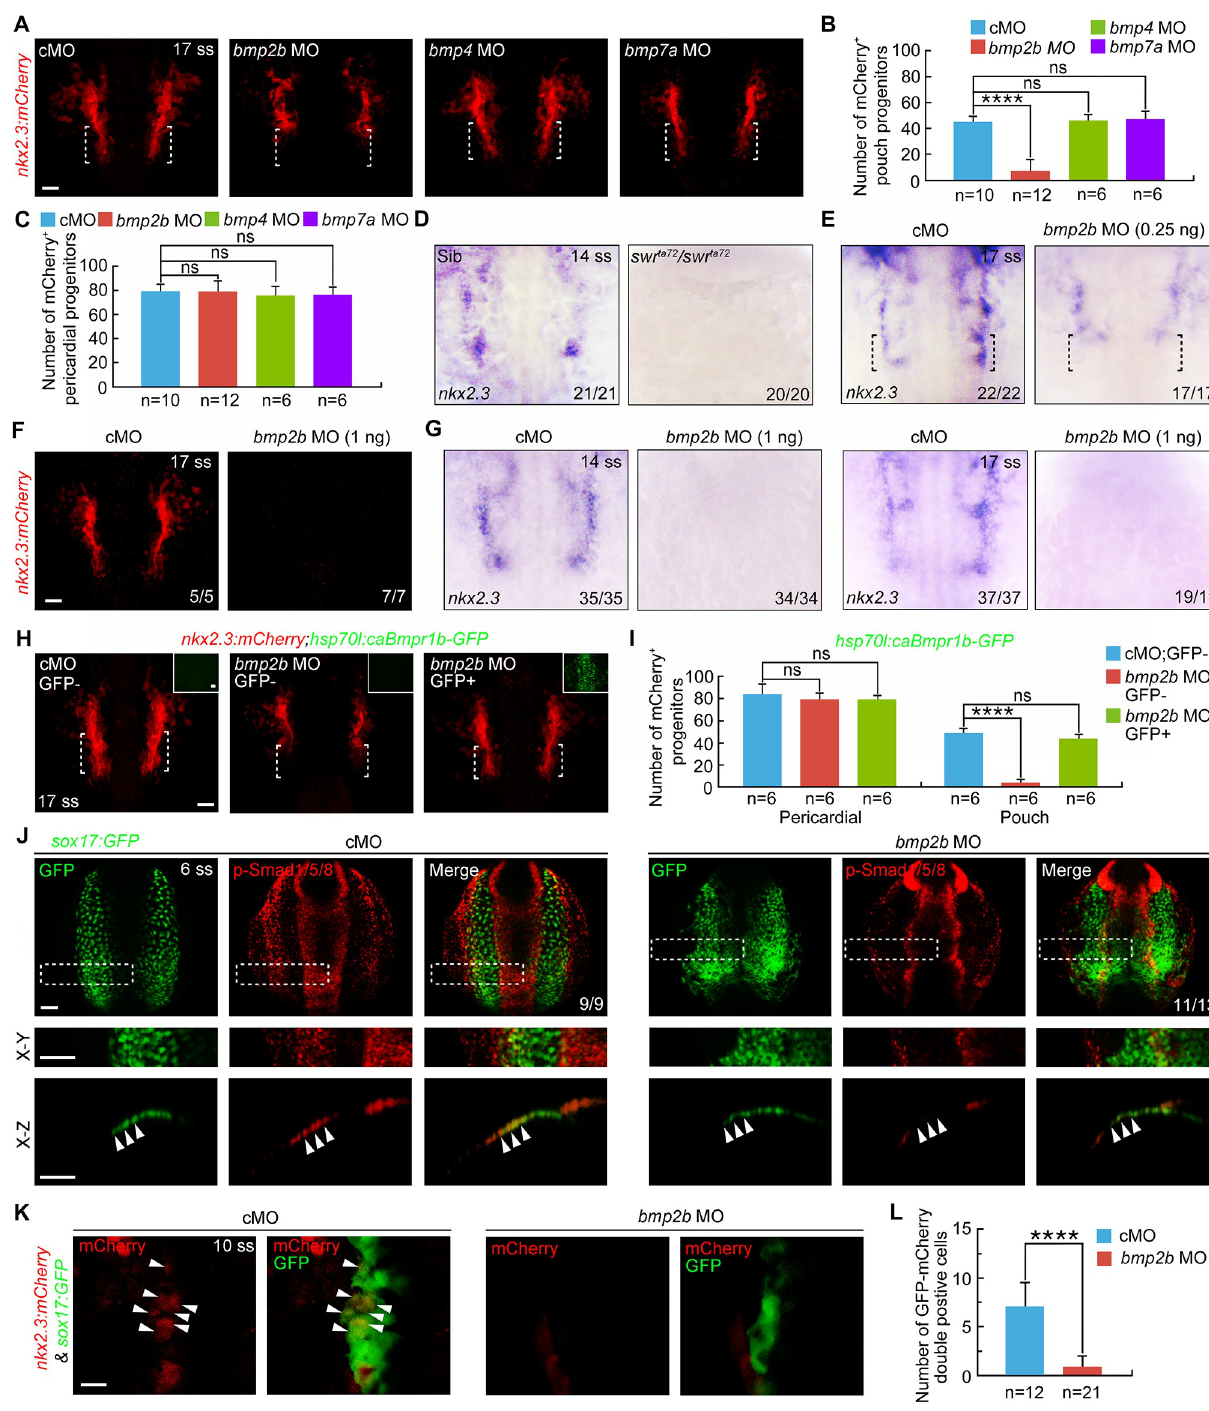
Fig 7. bmp2b is necessary for pharyngeal pouch progenitor specification. ( A ) mCherry fluorescence at the 17-somite stage in Tg(nkx2 . 3 : mCherry) embryos injected with 4 ng cMO, 0.25 ng bmp2b MO, 2 ng bmp4 MO, and 4 ng bmp7a MO, respectively. Scale bar, 50 μ m. ( B-C ) Quantification of the number of the mCherry + pouch progenitors (B) and the pericardial progenitors (C) from embryos of each group shown in (A). Student’s t -test, ���� P < 0.0001. ns, non-significant. ( D-E ) Alteration of the nkx2 . 3 expression pattern in swr ta72 mutants at the 14-somite stage (D) and embryos injected with 0.25 ng bmp2b MO at the 17-somite stage (E). Black dotted lines indicate the region where the pouch progenitors are located. ( F ) mCherry fluorescence at the 17-somite stage in Tg(nkx2 . 3 : mCherry) embryos injected with 1 ng cMO or bmp2b MO. Scale bar, 50 μ m. ( G ) The expression of nkx2 . 3 in wild-type embryos injected with indicated MOs. ( H-I ) mCherry fluorescence in heated Tg(nkx2 . 3 : mCherry;hsp70l : caBmpr1b-GFP)